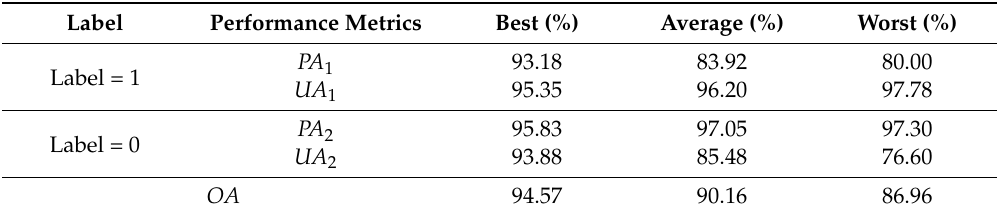
Table 4. The classification accuracy after introducing ESDs. Table 4 The classification accuracy after introducing ESDs.